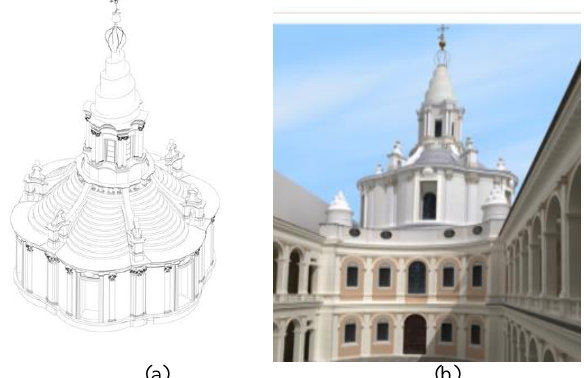
Figure 19. Sant’Ivo alla Sapienza. (a) Wireframe of the lantern; (b) Rendered 3D Model (plot by Chiara and Cecilia Manarini).